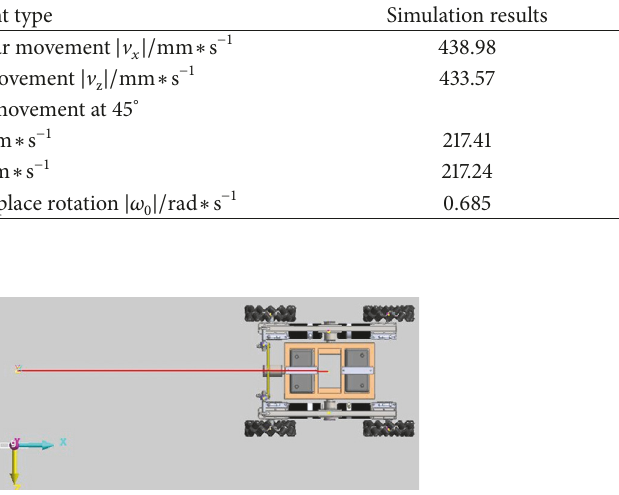
Figure 5: Trajectory of the MWP in straight-line motion.